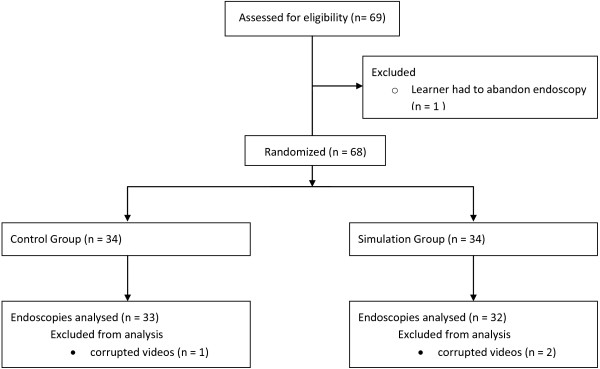
Flow of learners who participated in the study.